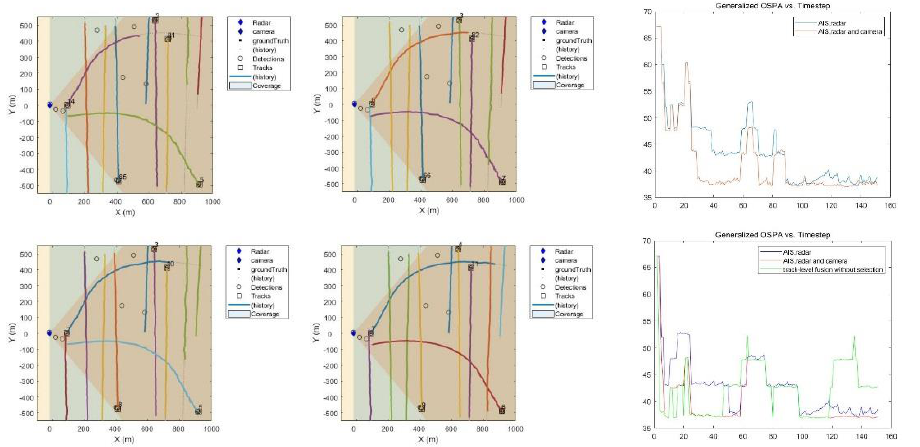
Fig. 6. Fusion with track-quality selection. First line: central-level fusion, left: AIS and radar, centre: AIS, radar and camera, right: corresponding OSPA curve. Second line: track-level fusion, left: AIS and radar, centre: AIS, radar and camera, right: corresponding OSPA